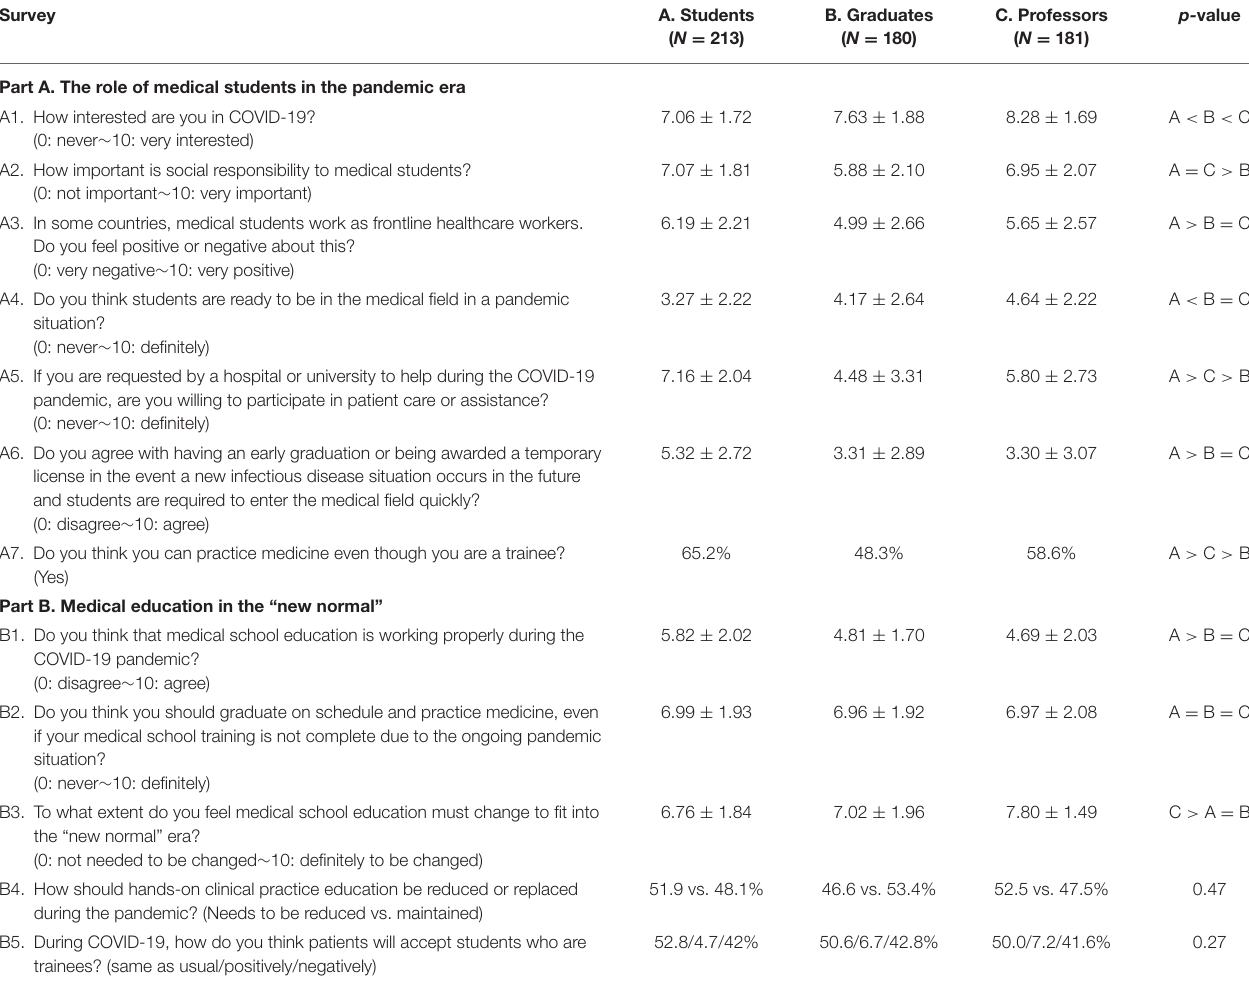
TABLE 2 | Responses of medical students, graduates, and professors to survey questionnaires.